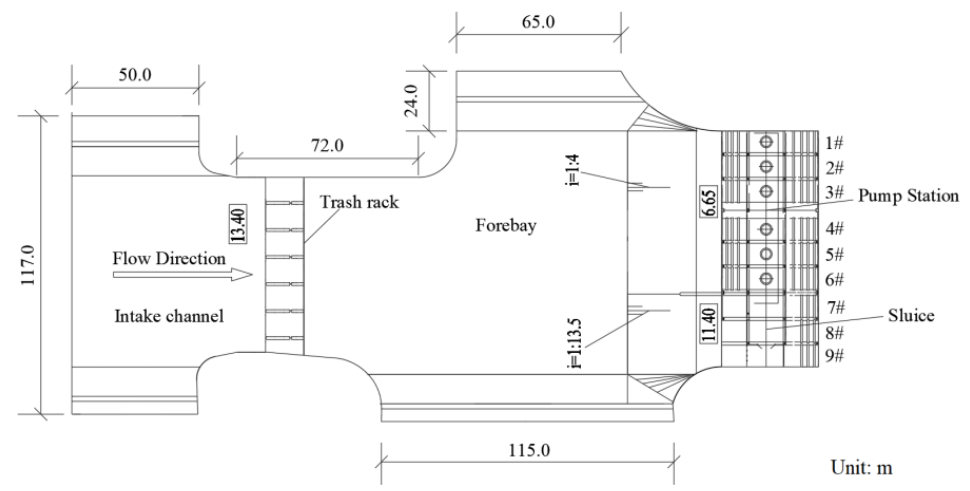
Figure 2. Layout chart of the calculated model.